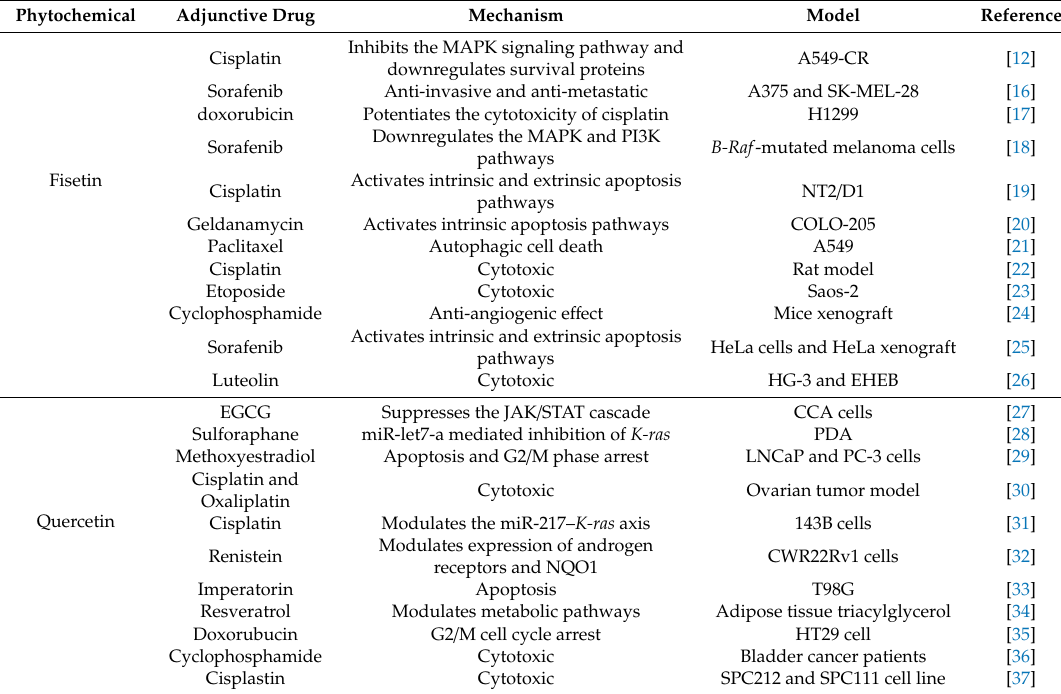
Figure 2. Figure showing regulation of different cancer associated signaling pathways. Deregulation of these pathways has been determined in human malignancies. Flavonoids control the deregulation of these pathways and cancer proliferation. Table 1. Synergistic effects.